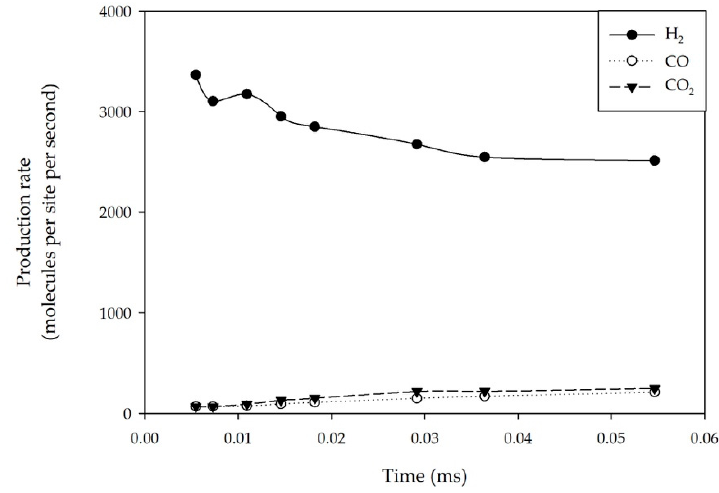
Figure 1. Fractional coverages as a function of time; time ( T ) = 850 K, pressure ( P ) = 1 bar, and 𝑦 (cid:3004)(cid:3009) 0.5.